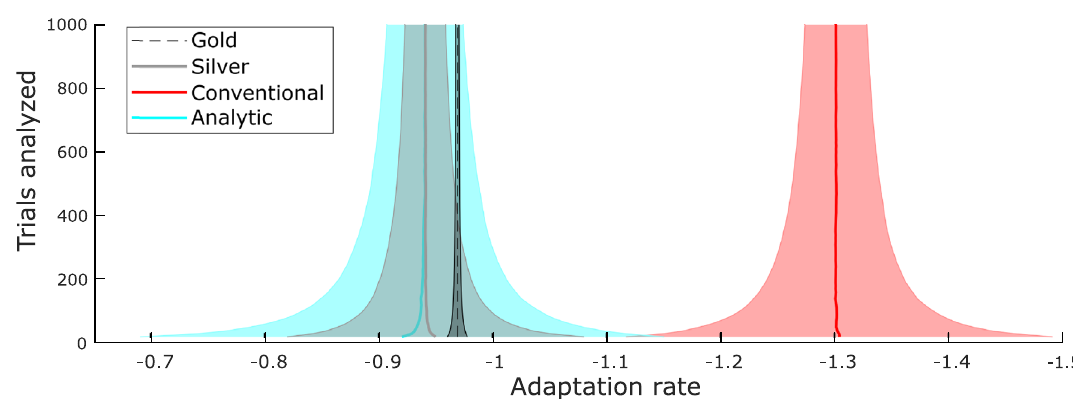
Figure 5. Comparison of different trial-by-trial adaptation rate calculation methods. ( a–b ) Simulation and parameter settings as in Fig. 3 for changing control noise with R = 1 ( a ) and changing sensory noise with Q = 1 ( b ). For clarity, the one standard deviation shaded range is shown only for the analytic results (see Figs. 3 and 4 for variability shading for other analysis methods). ( c , d ) Performance of each analysis method shown in ( a ) and ( b ) as measured using the mean squared error compared to the gold adaptation rate for changing control noise ( c ) and sensory noise ( d ).